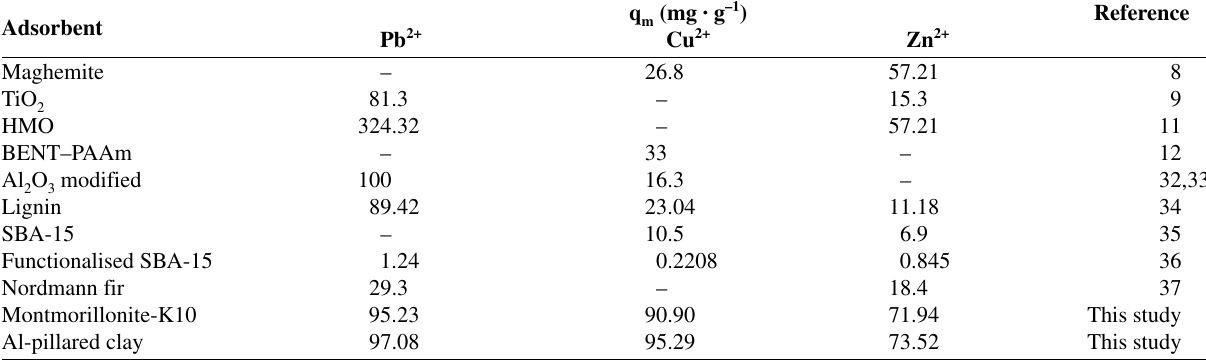
Table 6. Comparative analysis of adsorption efficiency of different adsorbents for Pb 2+ , Cu 2+ and Zn 2+ ions.